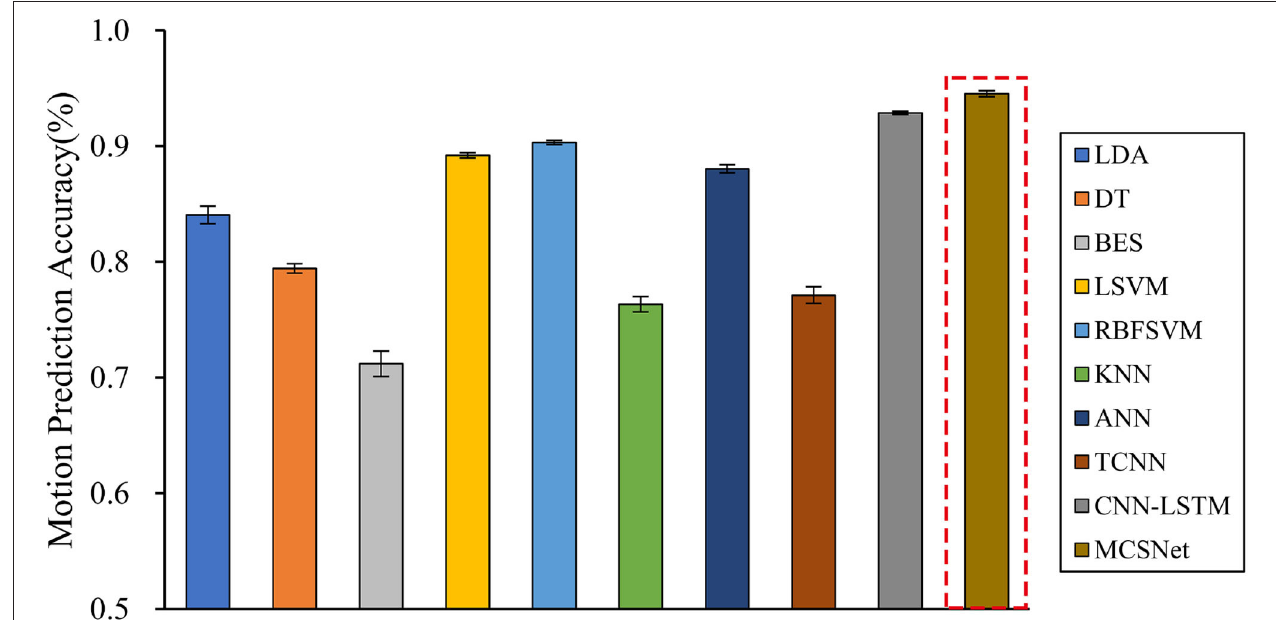
FIGURE 4 | Within-subject movement prediction performance, four-fold cross-validation is used to avoid the phenomenon of model overfitting, averaged over all folds and all subjects. Error bars denote two standard errors of the mean.